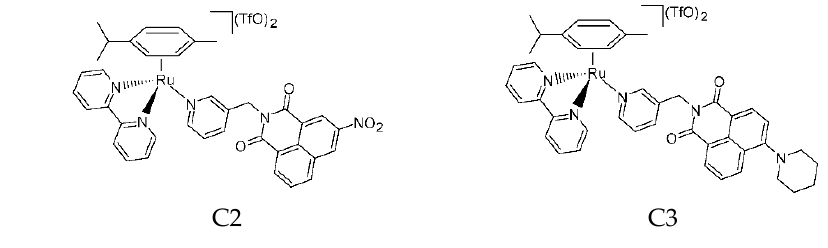
Figure 2. Structures of the complexes C1, C2, and